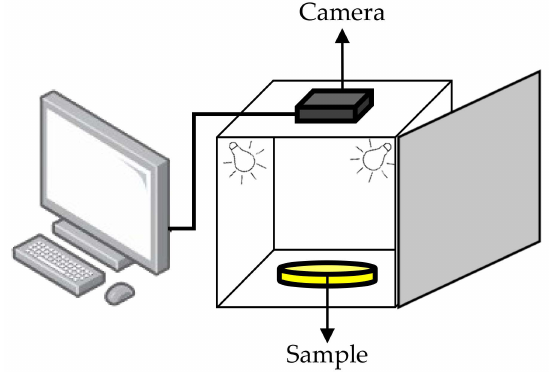
Figure 10. Set-up for the image analysis method. Other than that, the color information in the CIE L*a*b* values was also used to relate with the color standards such as Pfund, Lovibond and ASTM. The correlations between the color information obtained and the color standard can be observed after further mathematical analysis is performed.